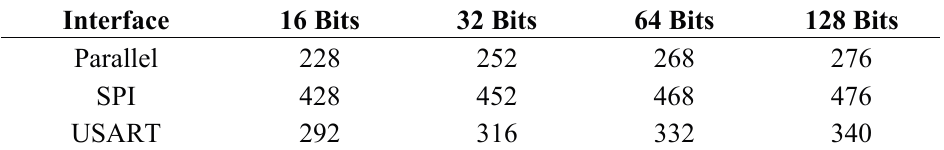
Table 5. Intrusion on code: Initialization and one event log